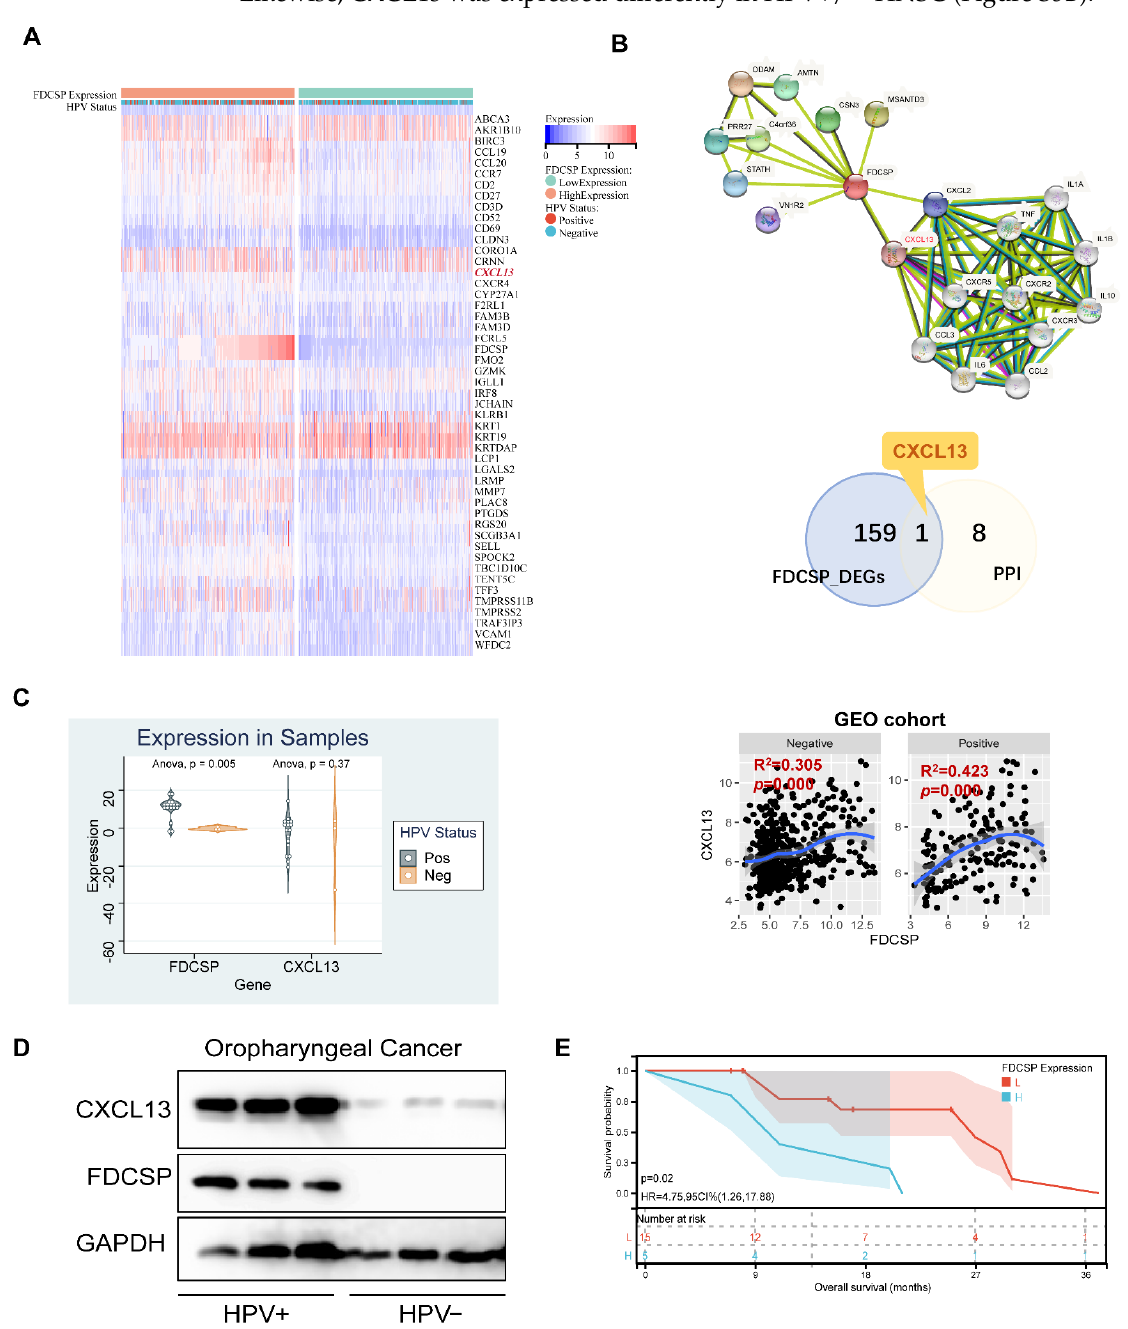
Figure 8. Analysis of FDCSP-related genes. ( A ) Heatmap of differential genes in the high/low FDCSP group in GEO-HNSCs (50/159 DEGs is shown). ( B ) String PPI network and Venn diagram of DEGs and PPIs. Correlation of FDCSP and CXCL13 in HPV+/ − HNSC in GEO cohorts. ( C ) FDCSP and CXCL13 mRNA expression in oropharyngeal cancer samples versus paired normal tissues. ( D ) FDCSP and CXCL13 protein expression in oropharyngeal cancer samples (3 HPV+ and 3 HPV − samples). ( E ) FDCSP mRNA expression relates with prognosis in oropharyngeal cancer samples (low group/L: FDCSP expression less than the median and high group/H: FDCSP expression more than the median). In HNSC tissues collected from Nanfang Hospital (n = 20), there were 17 HPV+ and 3 HPV − samples. We detected mRNA expression of FDCSP and CXCL13. FDCSP